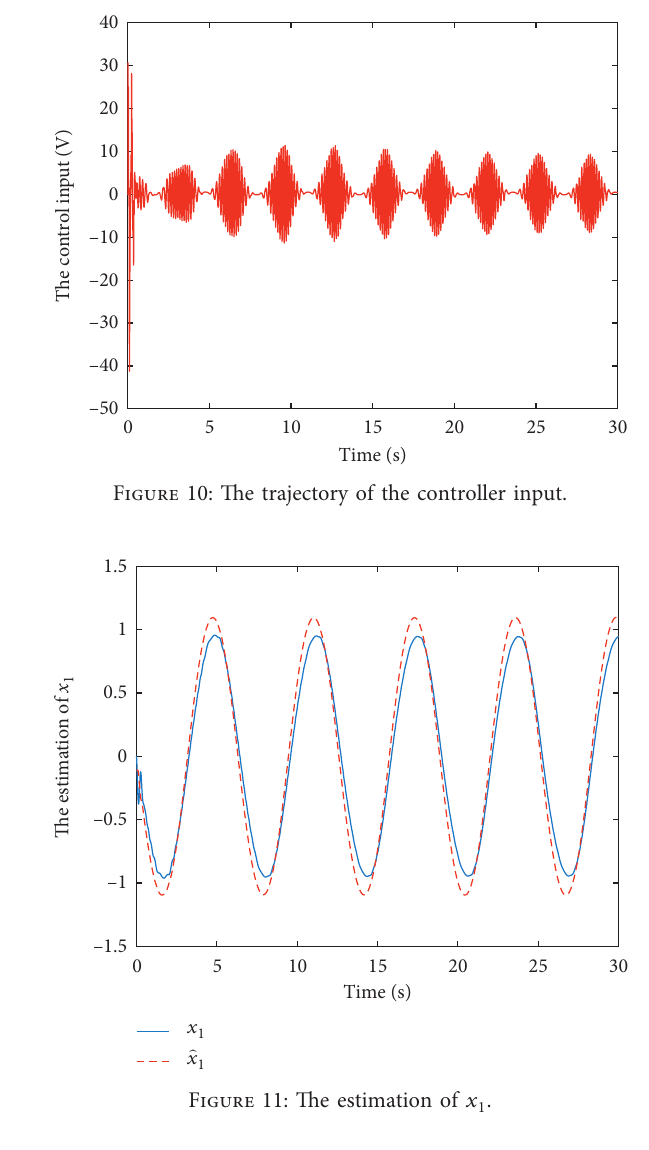
Figure 11: The estimation of x